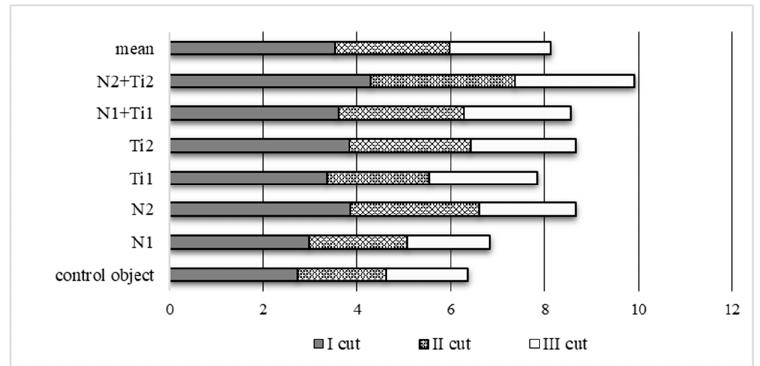
Figure 1. The yield of Festulolium braunii (t ha − 1 DM) across harvest, a three-year average. N 1 –80 kg N ha − 1 ; N 2 –160 kg N ha − 1 ; Ti 1 –Tytanit 0.2%; Ti 2 –Tytanit 1%. LSD 0.05 for: A-0.492 (cuts); B-0.253 (treatment); A × B-ns; B×A-ns (interaction).